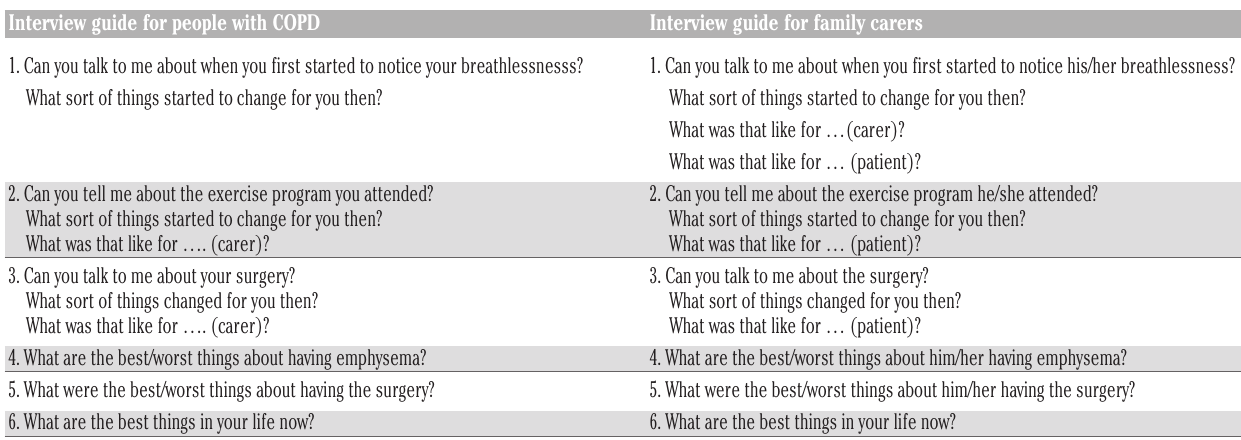
Interview guide for people with